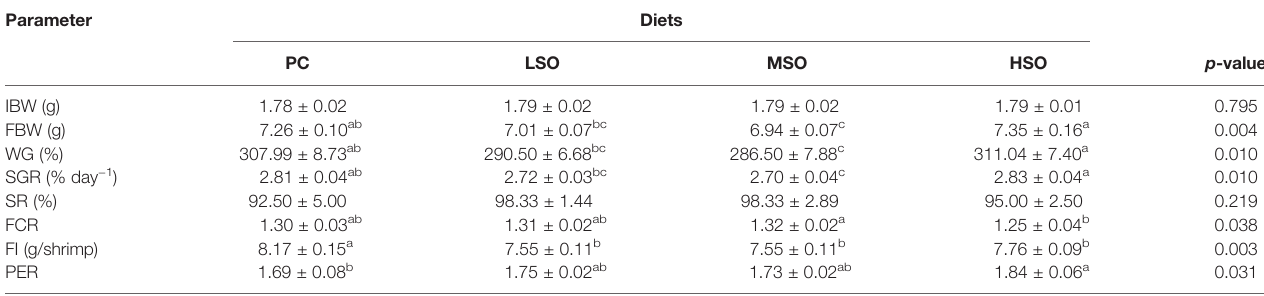
TABLE 5 | Growth performance of Paci fi c white shrimp fed with experimental diets.